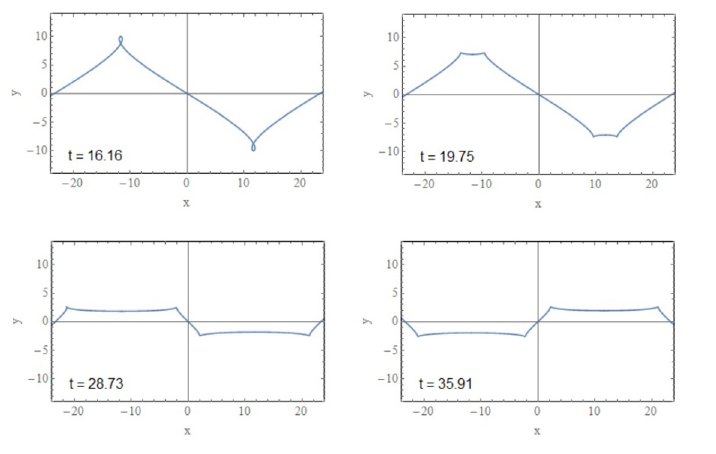
Figure 25 . Timeslices of an analytical solution in flat space. The first plot has no cusps. Cusps in the other three plots move with the speed of